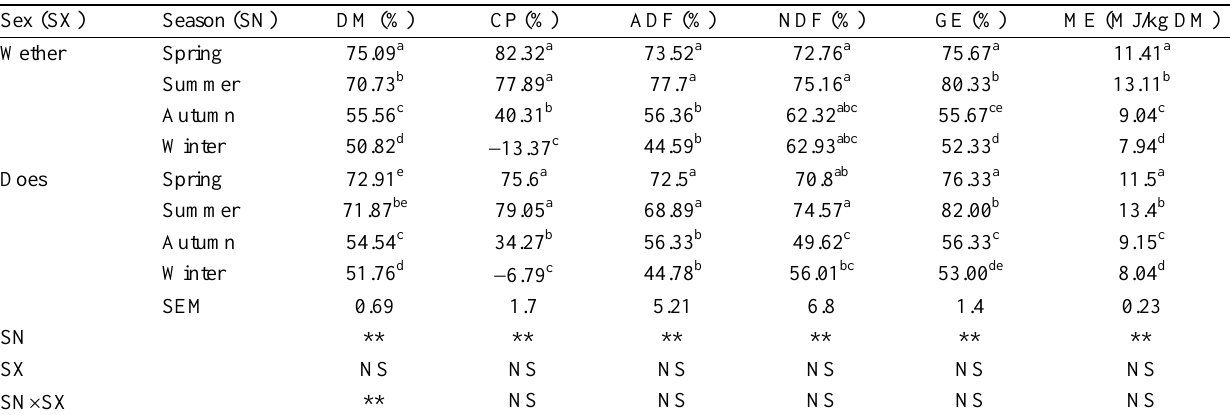
Table 5. Metabolizable energy content and nutrient digestibility of diets consumed by cashmere goats grazing on L. chinensis pasture Sex (SX) Season (SN) DM (%) CP